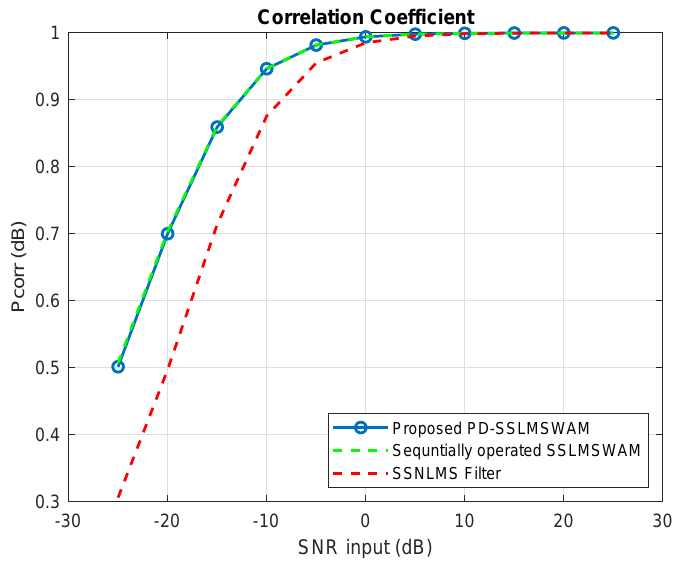
Figure 15. Correlation coefficient.